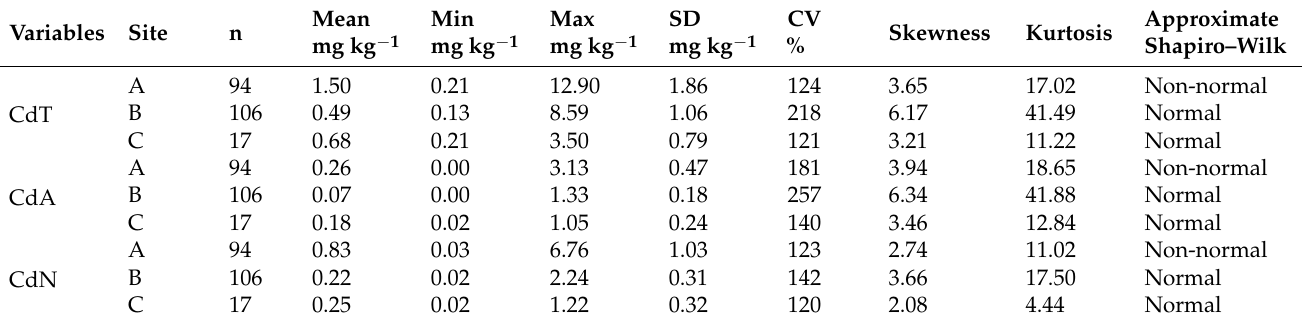
Table 1. Descriptive statistics of Cd content in soil and